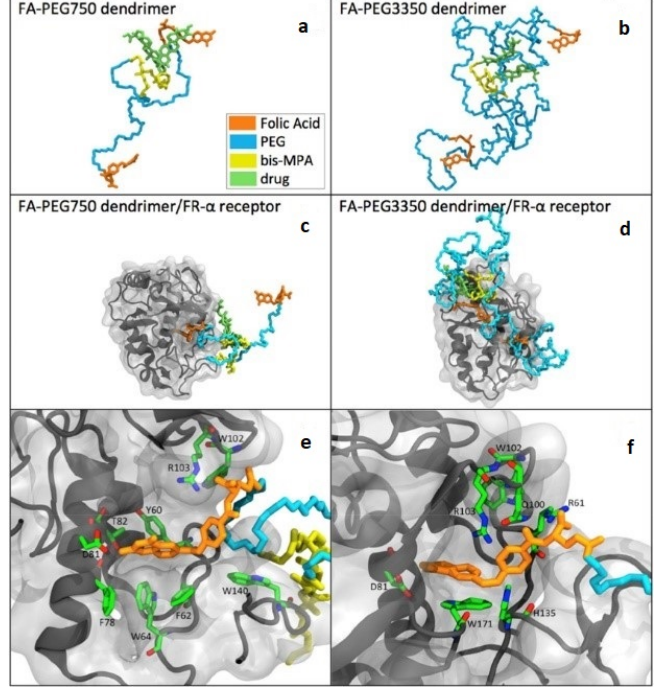
Figure 8. Snapshots of dendrimers complexed with drug, folic acid, and PEG (( a ) PEG750 and ( b ) PEG3350), and those interacting with a folate receptor ( c – f ). (Reprinted with permission from [186]. Copyright (2017) Elsevier).